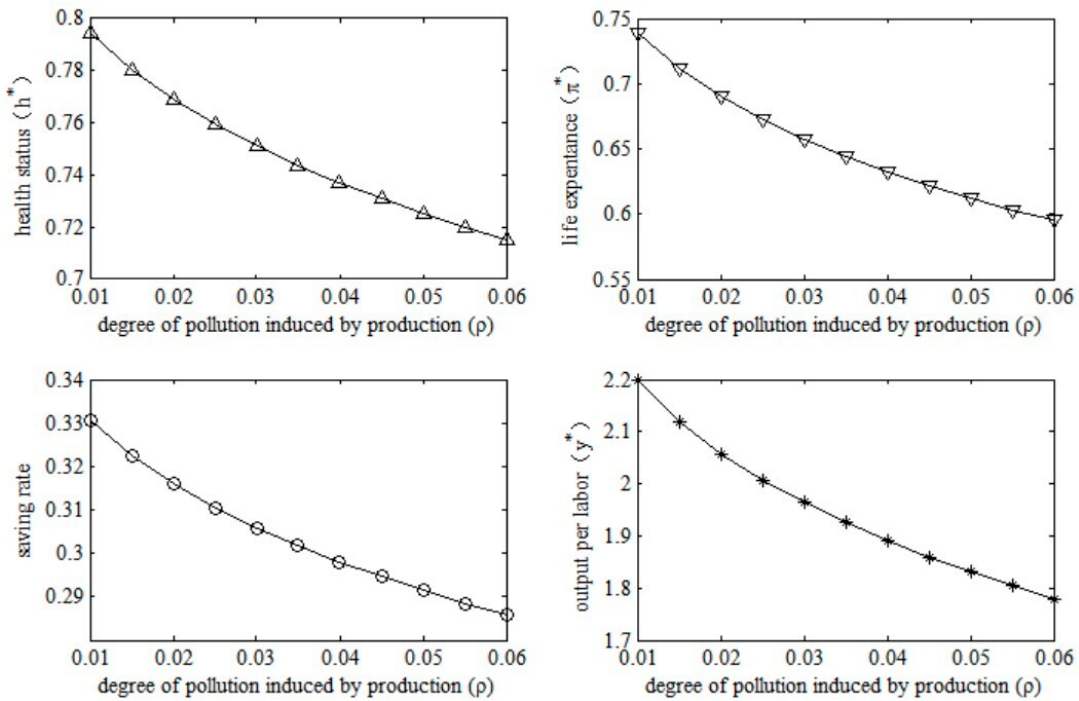
Figure 5. Socioeconomic effects of degree of pollution induced by production. Note: * of this figure represents the numerical solutions of these variables in equilibrium. The same is as below.